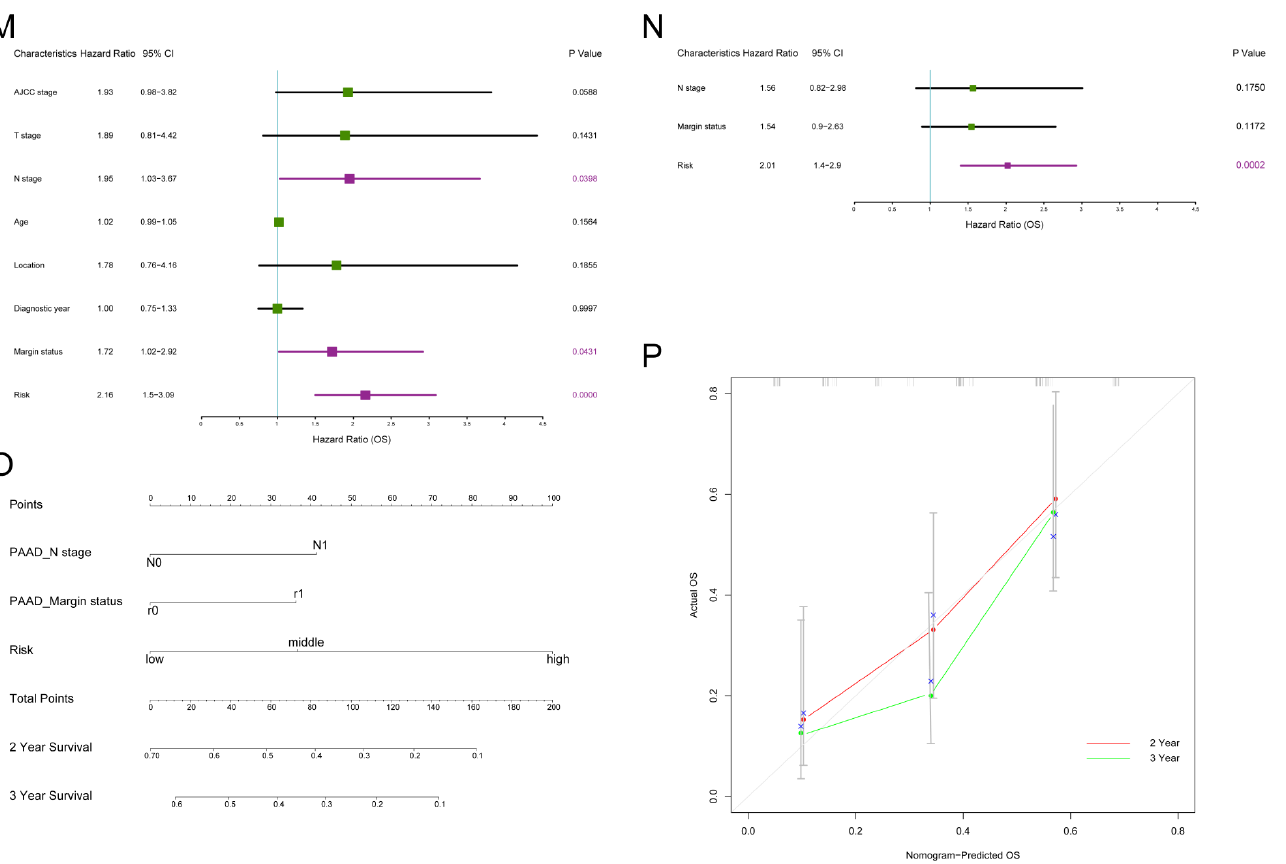
Figure 2. The construction of the risk score model and nomogram to predict the OS of PDAC patients. ( A – D ) Construction of the prognostic model in the train set in TCGA_PAAD: KM curve showing different OSs between high- and low-risk groups ( A ), ROC curve was used to evaluate the accuracy of the prognostic model for 1-/1.5-/2-year OSs ( B ), risk score distribution of subjects in the train set ( C ), and survival status scatter plot ( D ); ( E – H ) internal validation of the prognostic model in the validation set; ( I – L ) internal validation of the prognostic model in the all set; ( M , N ) univariate and multivariate cox regression analysis of risk factors of OS in PDAC; purple boxes represent p < 0.05 in the forest plot; ( O ) the nomogram was used to predict 2/3-year OSs of PDAC patients; ( P ) calibration curve was drawn to evaluate the consistency of predicted and actual